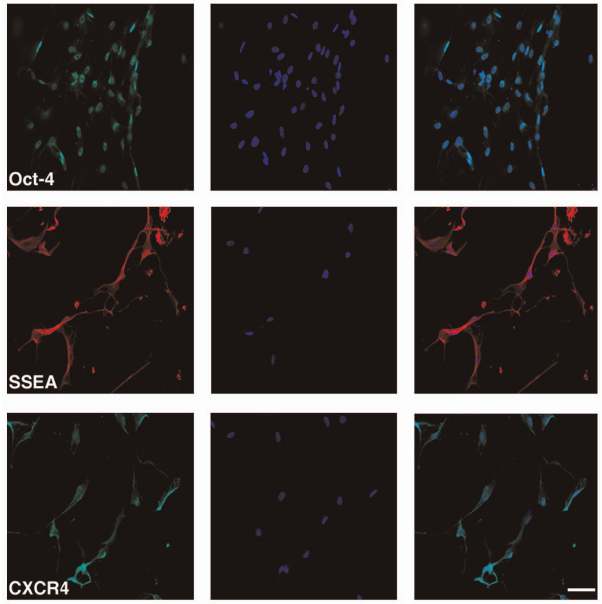
Figure 1. DPCs display stem cell surface markers. Subcultured DPCs at day 3 in culture expressed stem cell phenotypes including Oct- 4, SSEA, and CXCR4. Left panels: phenotypic marker; Middle panels: DAPI; Right panels: Merged. Scale bar =75 m m.